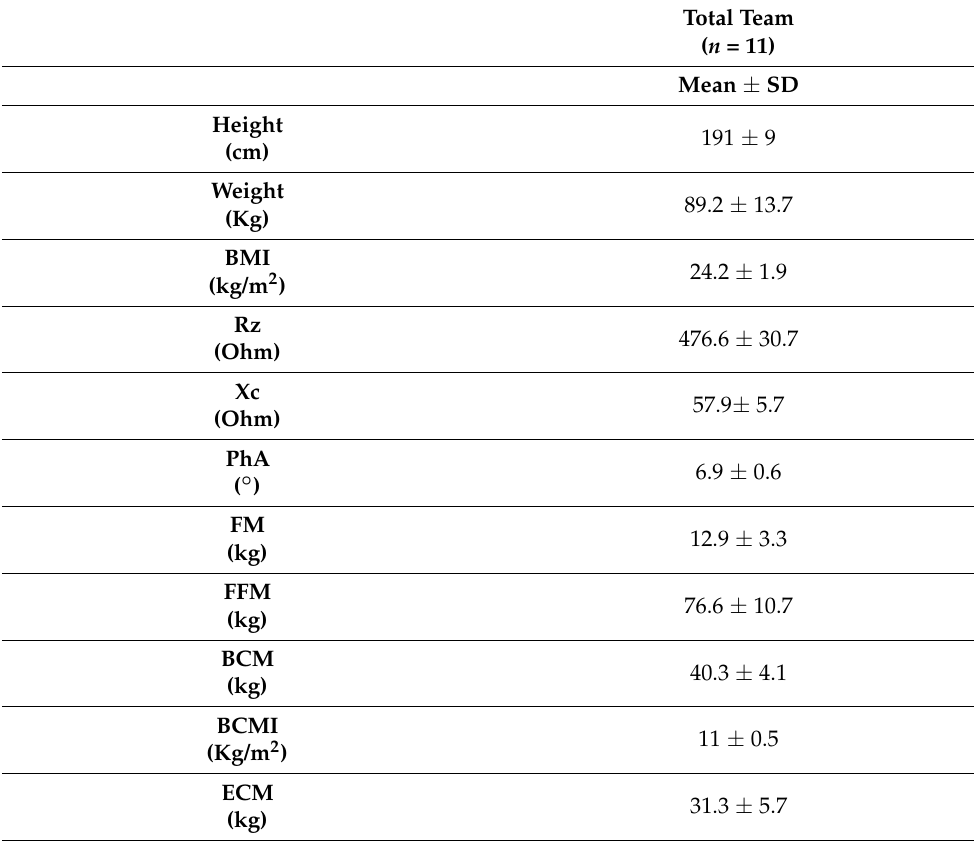
Table 1. Anthropometric, bioimpedance parameters, and MEDAS score in the total team of volleyball athletes at enrollment